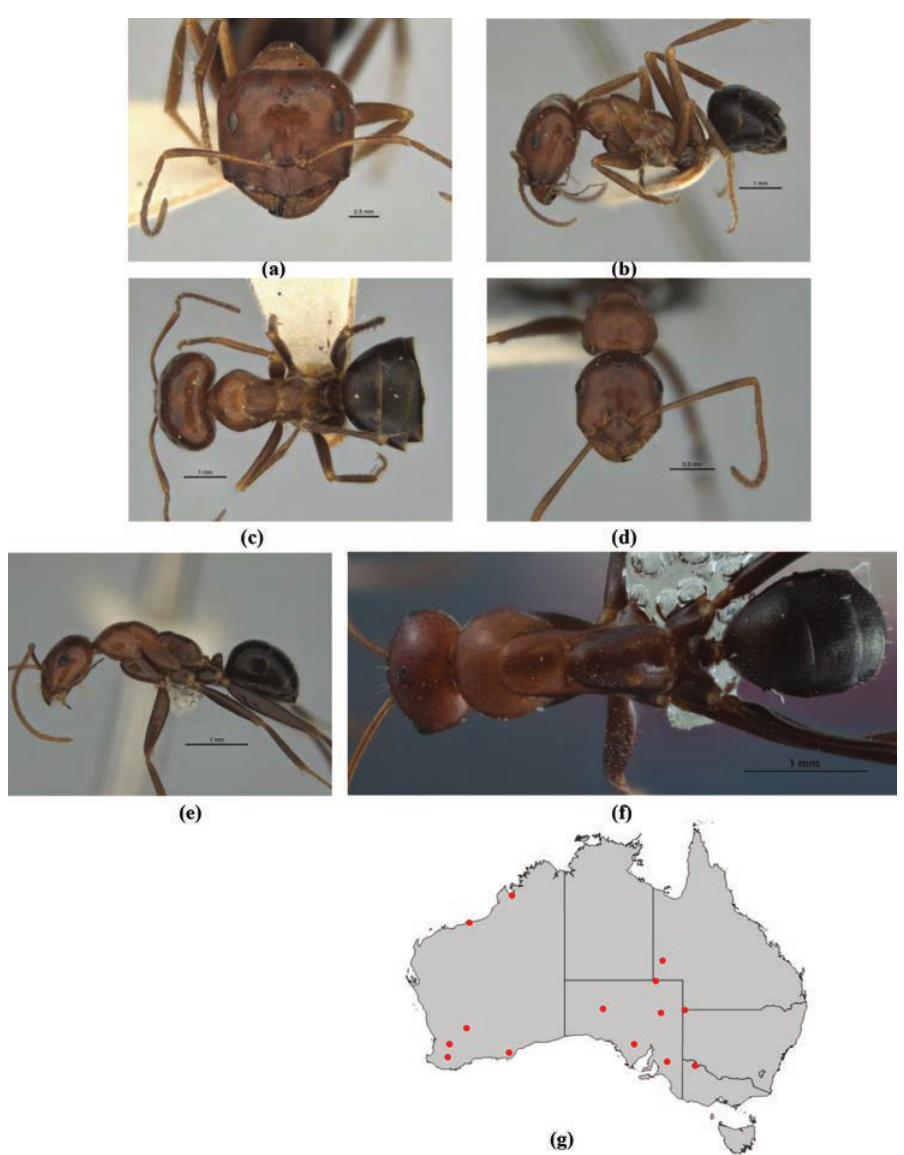
Figure 18. Melophorus praesens sp. n.: major worker (JDM32-001480) frons ( a ), profile ( b ) and dorsum ( c ); minor worker holotype (ANIC32-900117–top ant) frons ( d ), profile ( e ) and dorsum ( f ); distribution map for the species ( g ). Low resolution scale bars: 1 mm ( b, c ); 0.5 mm ( a, d–f ). Low resolution scale bars: 1 mm ( b, c, e ); 0.5 mm ( a, d ). nal insertion. Anteromedial clypeal margin narrowly convex and protruding, clypeal midpoint distinctly notched; clypeal psammophore set at or just above anterior clypeal margin; palp formula 6,4. Five mandibular teeth in minor worker; mandibles